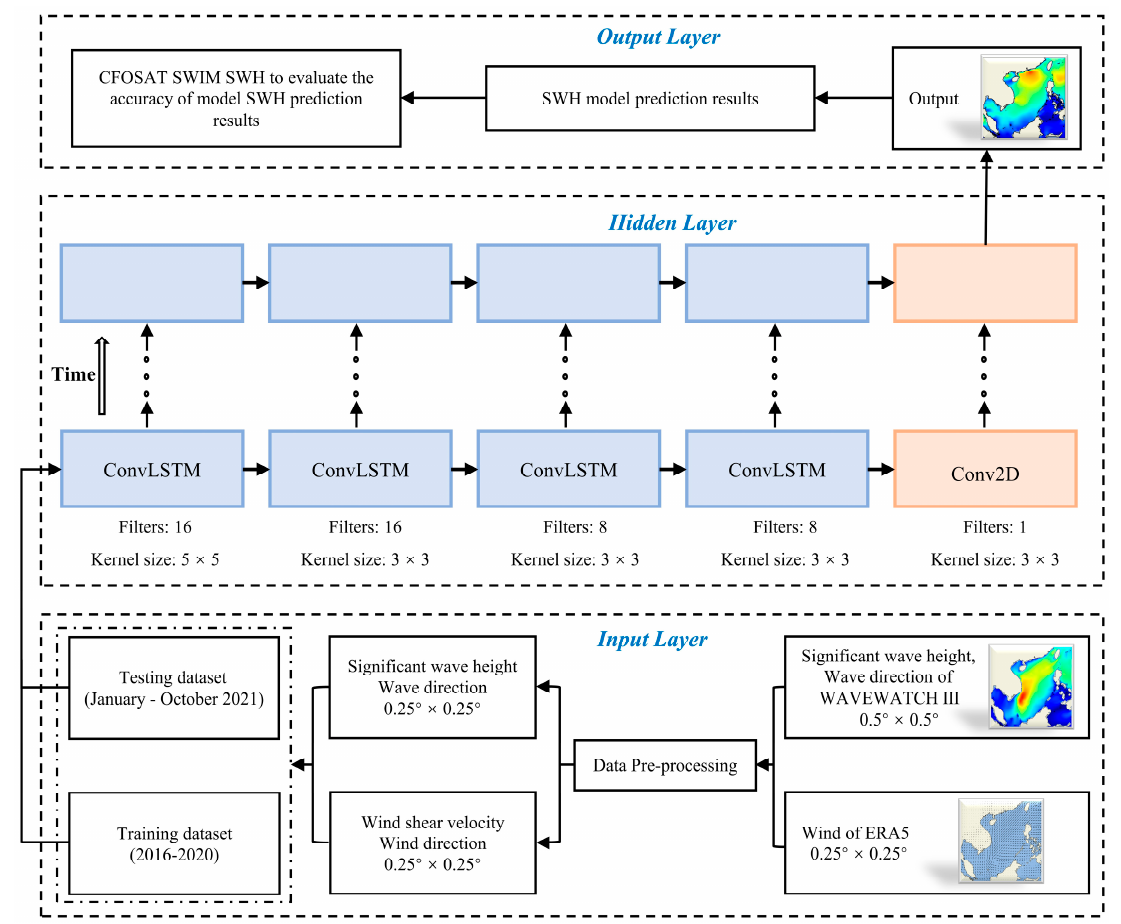
Figure 2. The overall structure of the SWH prediction model in the SCS.